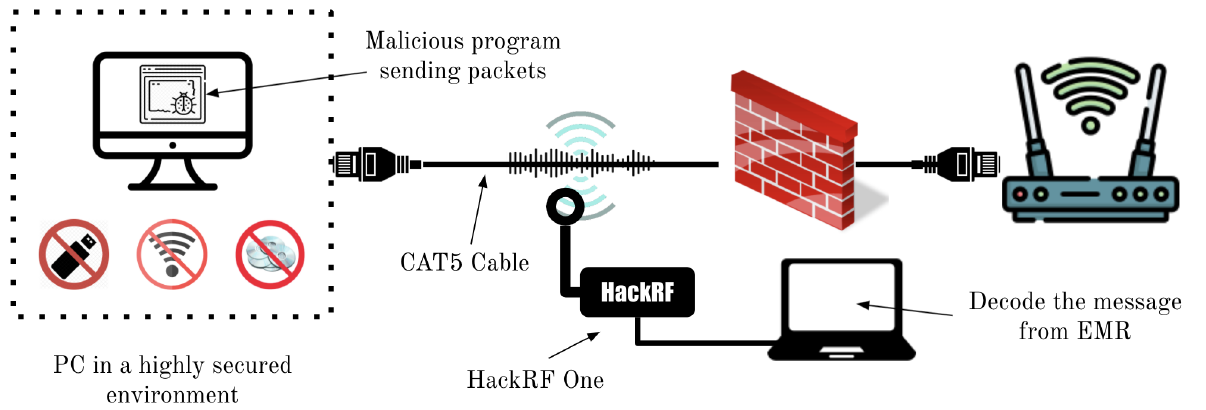
Figure 1. Illustration of the proposed attack model and experimental setup. Malware on an infected target computer manipulates the network communication, resulting in deliberate EMR patterns used to transmit a covert signal to a nearby